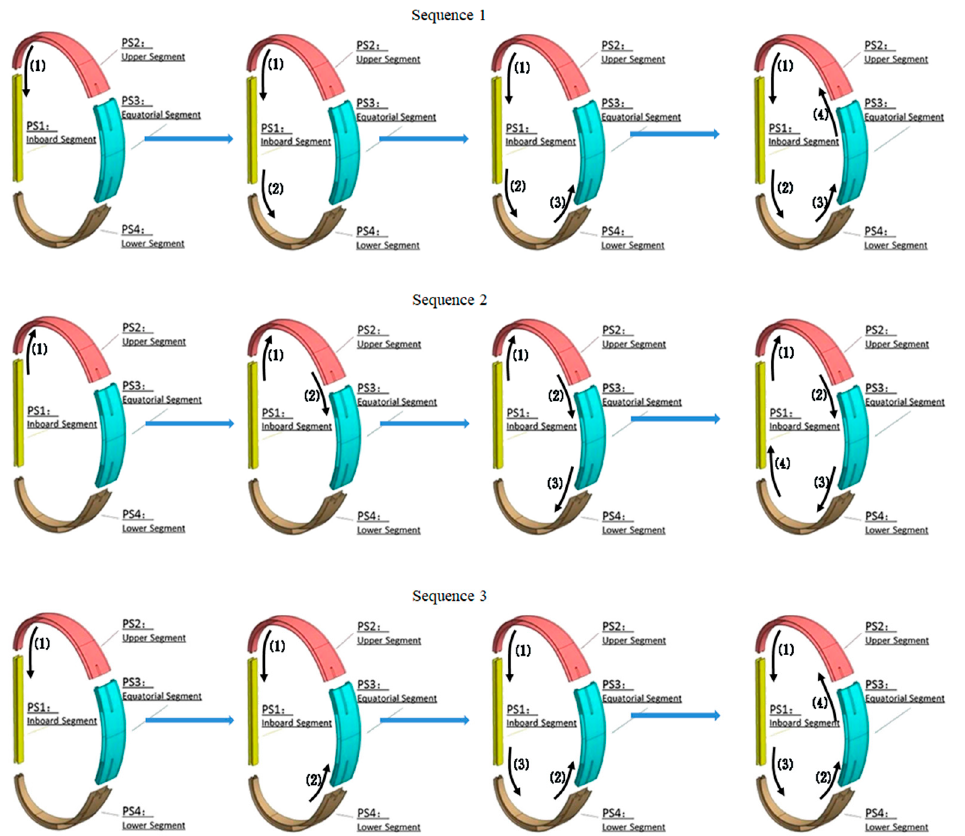
Figure 17. Three welding sequences of the 1/32 VV mock-up: welding anticlockwise in sequence 1, welding clockwise in sequence 2, and welding counterpoint in sequence 3.